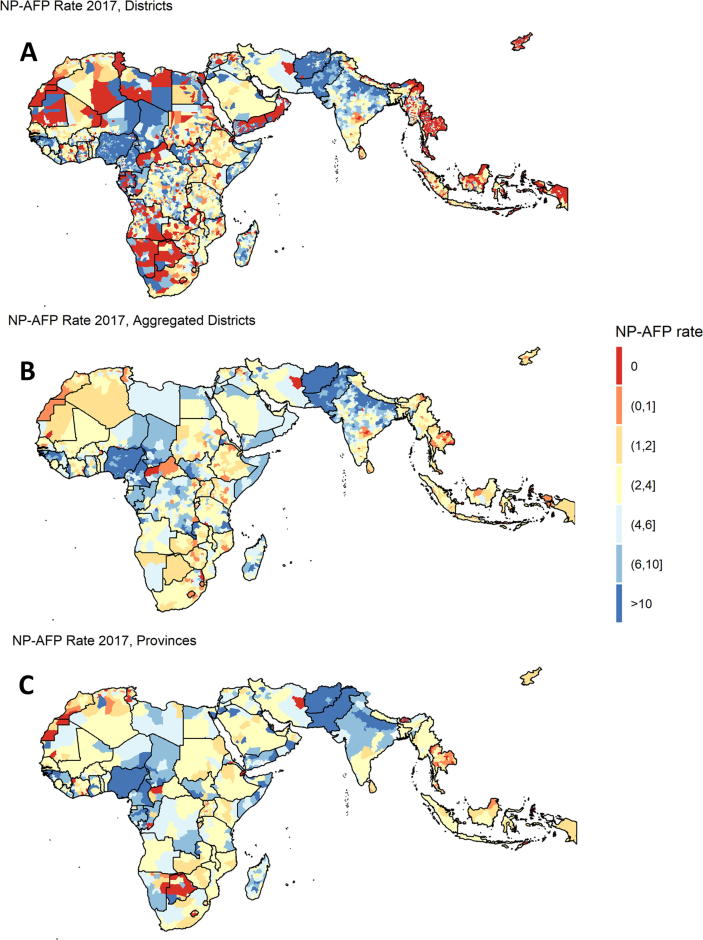
NPAFP Rates in Subnational Areas.